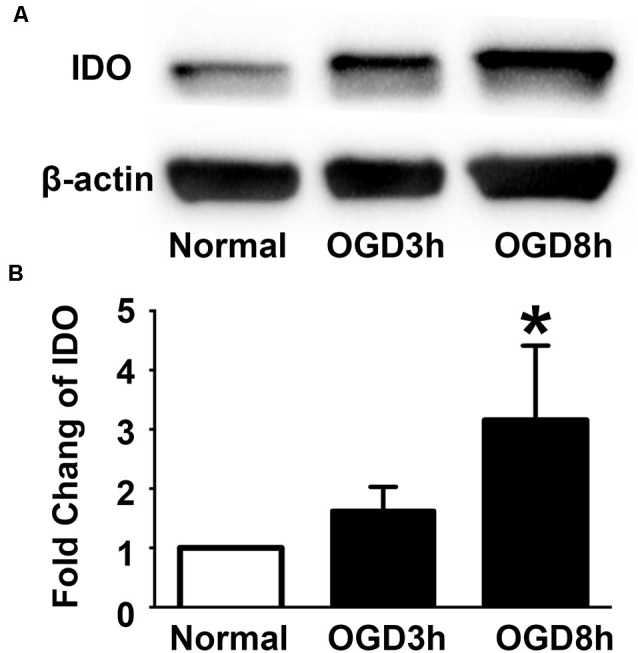
Indoleamine 2,3-dioxygenase (IDO) expression increased in the NPCs after oxygen glucose deprivation (OGD). (A) Western blot results showed that the expression of IDO after 3 and 8 h of OGD in hESC-derived NPCs. β-actin was an internal control. (B) The bar graph represented the semi-quantification of IDO expression. N = 5 per group, *p < 0.05, compared to the control.